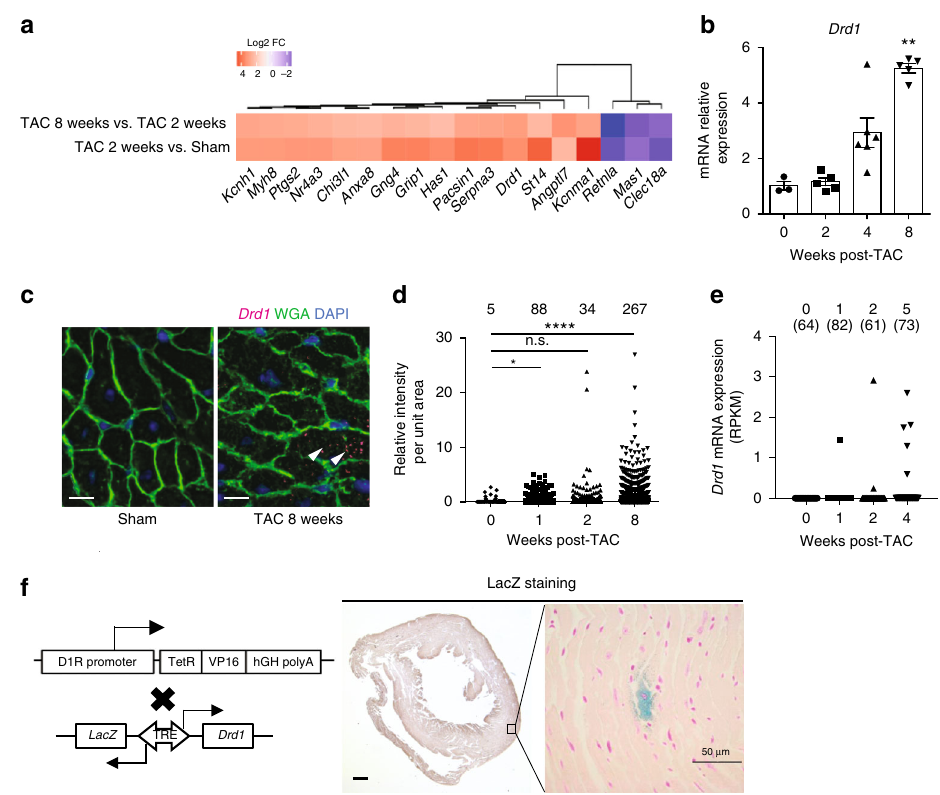
Fig. 1 Appearance of D1R-expressing cardiomyocytes in failing heart. a Heatmap showing the genes whose expression was increased or decreased during the progression of heart failure. Tissue samples were collected from sham-operated, 2 and 8 weeks after TAC-operated hearts (sham, n = 2; 2 weeks, n = 3; and 8 weeks, n = 1). b Bar graph showing relative expression of Drd1 in heart tissues after TAC operation analyzed by qPCR (0 week: sham- operated, n = 3; 2 weeks, n = 5; 4 weeks, n = 6; and 8 weeks, n = 5). Data are shown as mean and s.e.m. Statistical signi fi cance was determined by Kruskal – Wallis test followed by Dunn ’ s multiple comparisons test; ** p = 0.0077 versus 0 week. c Representative images of single-molecule fl uorescence in situ hybridization against Drd1 (magenta). Heart tissue was collected 8 weeks after the sham operation (sham) or TAC operation (TAC 8 weeks). Tissue samples were stained with WGA (green), and DAPI (blue). Arrowheads indicate the positive staining of Drd1 mRNA. Scale bars, 10 µ m. d Dot plots showing relative fl uorescent intensity of Drd1 in CMs normalized by the area of each cells. A total of 680, 1935, 2344, and 2180 CMs from one mouse for each time point were analyzed. Statistical signi fi cance was determined by Kruskal – Wallis test followed by Dunn ’ s multiple comparisons test; * p = 0.021; **** p < 0.0001 versus sham (0 week); n.s. not signi fi cant. The numbers above the dot plots indicate the number of CMs whose normalized intensity was more than one. e Dot plots showing the expression of Drd1 in CMs isolated from the heart tissue of sham- and TAC-operated mice at 1, 2, and 4 weeks after the operation ( n = 2 each) evaluated by single-cell RNA-seq. The numbers above the dot plots indicate the number of Drd1 -expressing CMs followed by the number of CMs analyzed. f Left: generation of D1R LacZ reporter mice ( D1R-tTA/TRE-D1R/lacZ mice). tTA tetracycline transactivator, TRE tetracycline responsive element, TetR tetracycline repressor, VP16 virion protein 16, hGH human growth hormone. Right: representative image of LacZ staining of heart tissue from TAC-operated mice (4 weeks after surgery). Scale bar 500 μ m (left) and 50 μ m (right). Nucleus is counterstained in magenta and LacZ-stained cells in